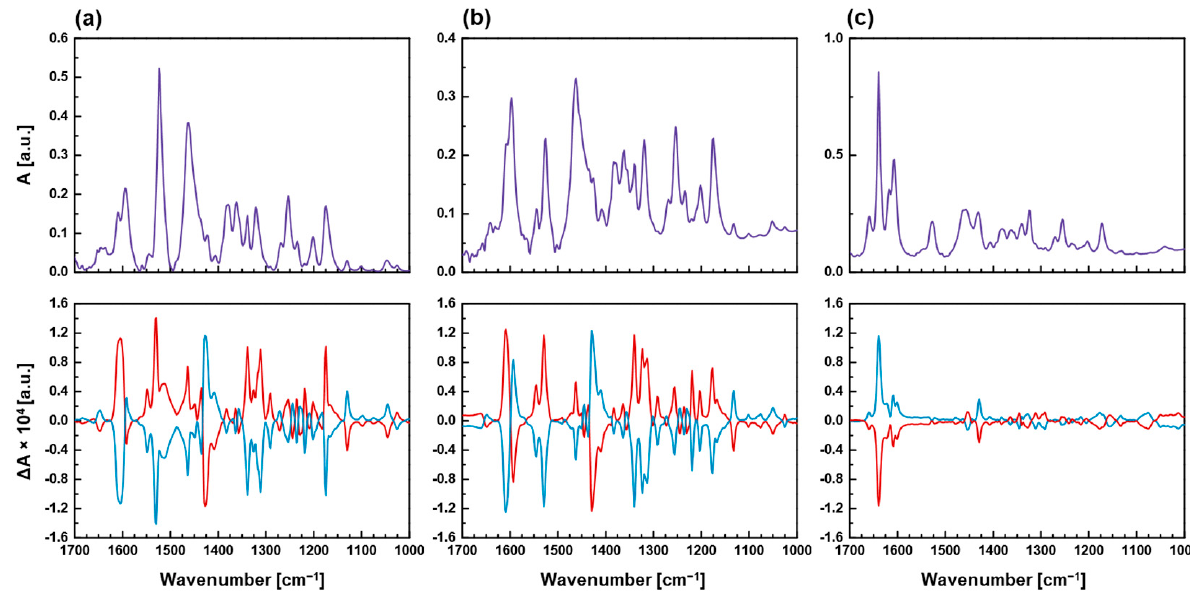
Figure 7. Solid-state IR spectra of a mixture of equal amounts of both hands of the complexes (purple line) and solid-state VCD spectra of ( a ) Co(L) · CS 2 , ( b ) Co(L), and ( c ) Co(L)(NO) (blue line complexes of L S,S ; red line complexes of L R,R ).